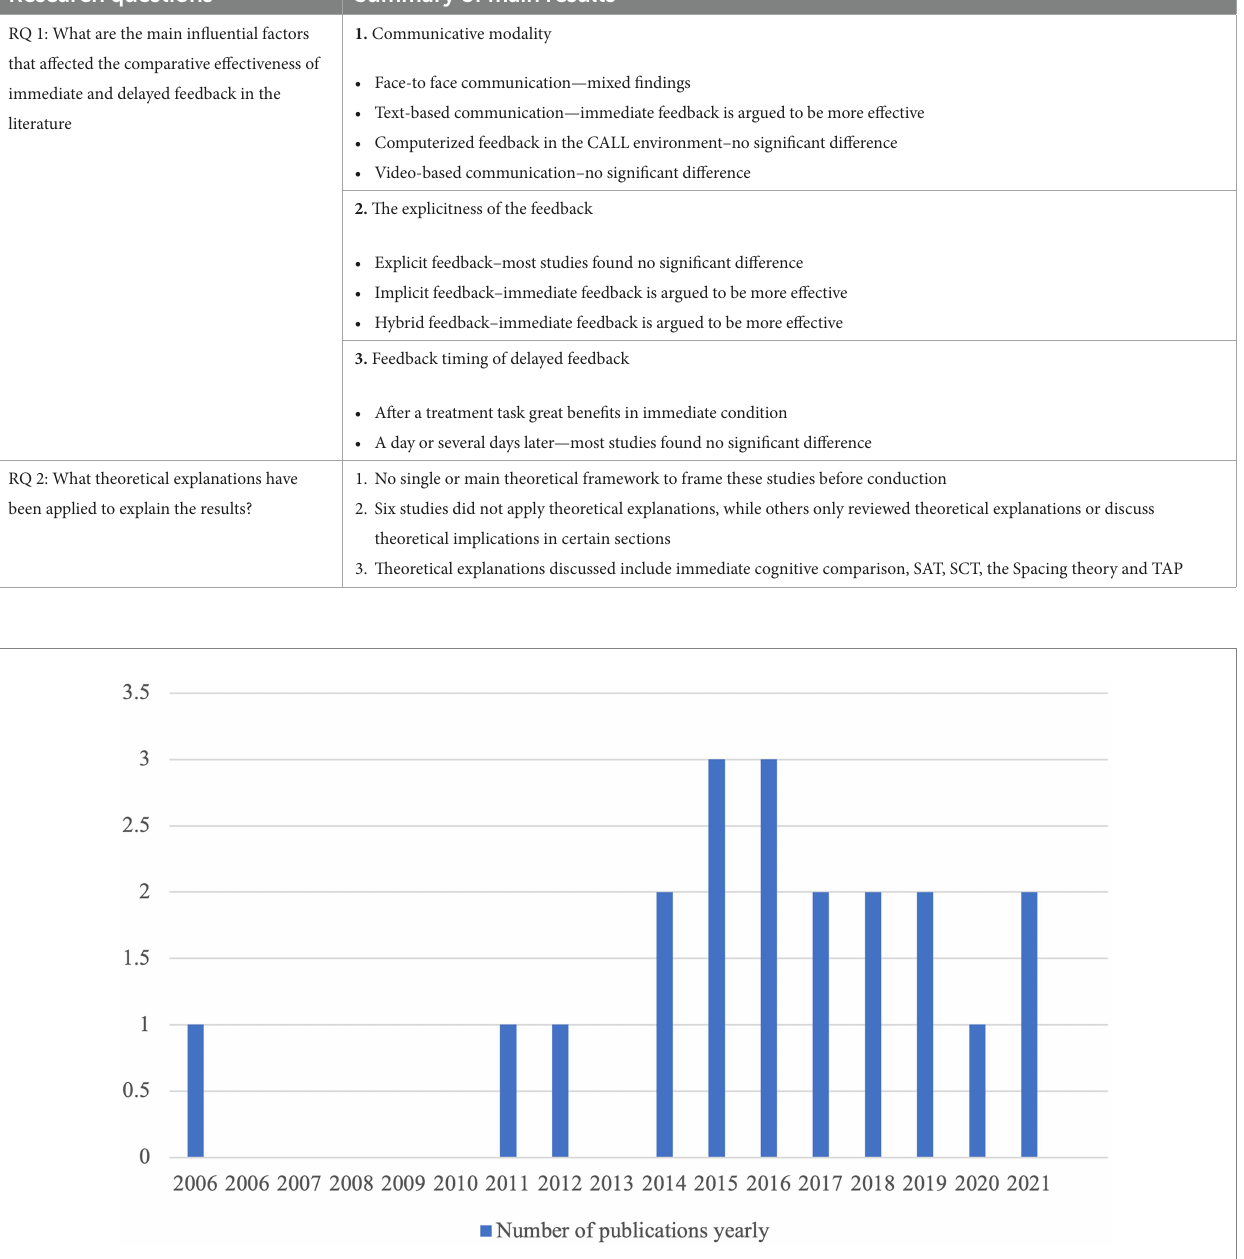
FIGURE 2 The yearly distribution of the publications included in this systematic review (2006–2021).